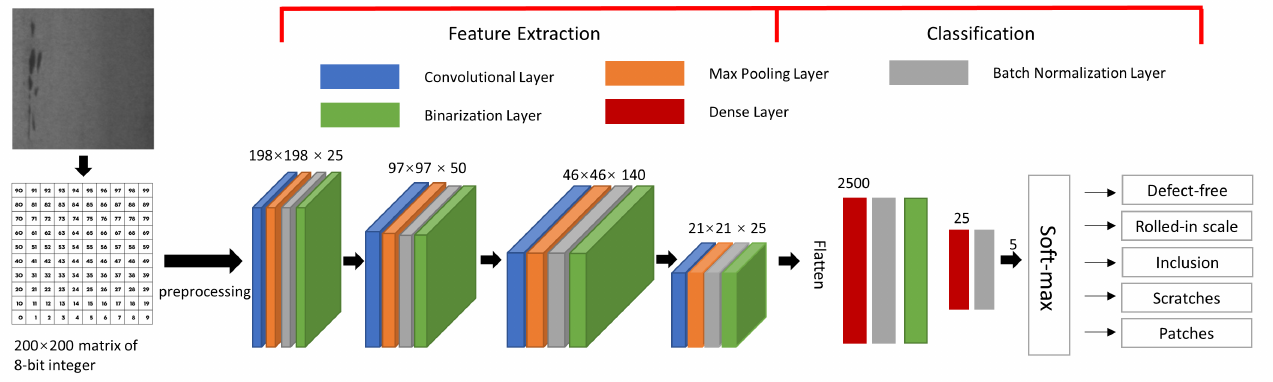
Figure 1. Binarized neural network